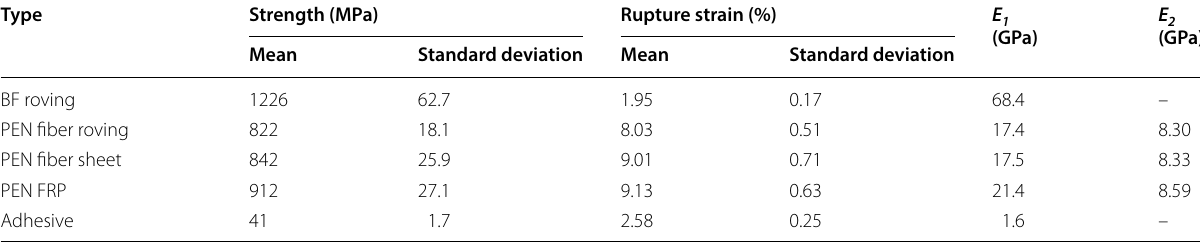
1. E 1 secant modulus corresponding to 1% strain; 2. E 2 = FRP is 100% of fiber by vol.; average of twelve tests for BF and ten tests for PEN